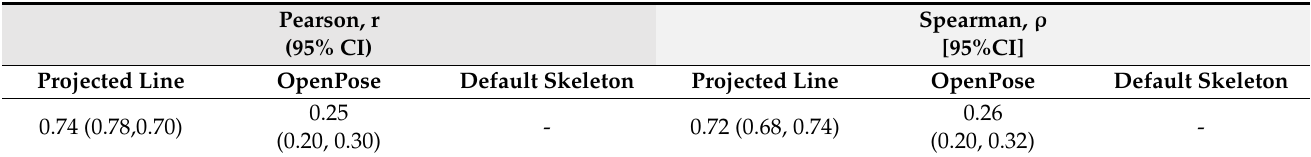
Table 4. In walking test, correlation coefficients obtained by the projection lines method based on RCNN Mask proposed in this work, OpenPose software and the Kinect default skeleton, versus the IMUs gold standard. All Pearson’s and Spearman’s p -values < 0.0001.